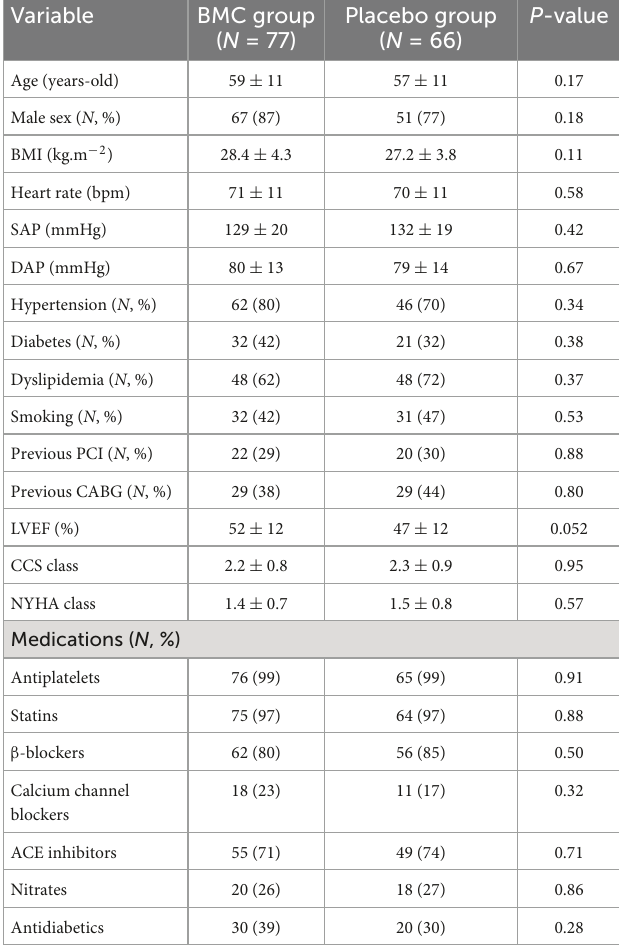
TABLE 1 Baseline clinical